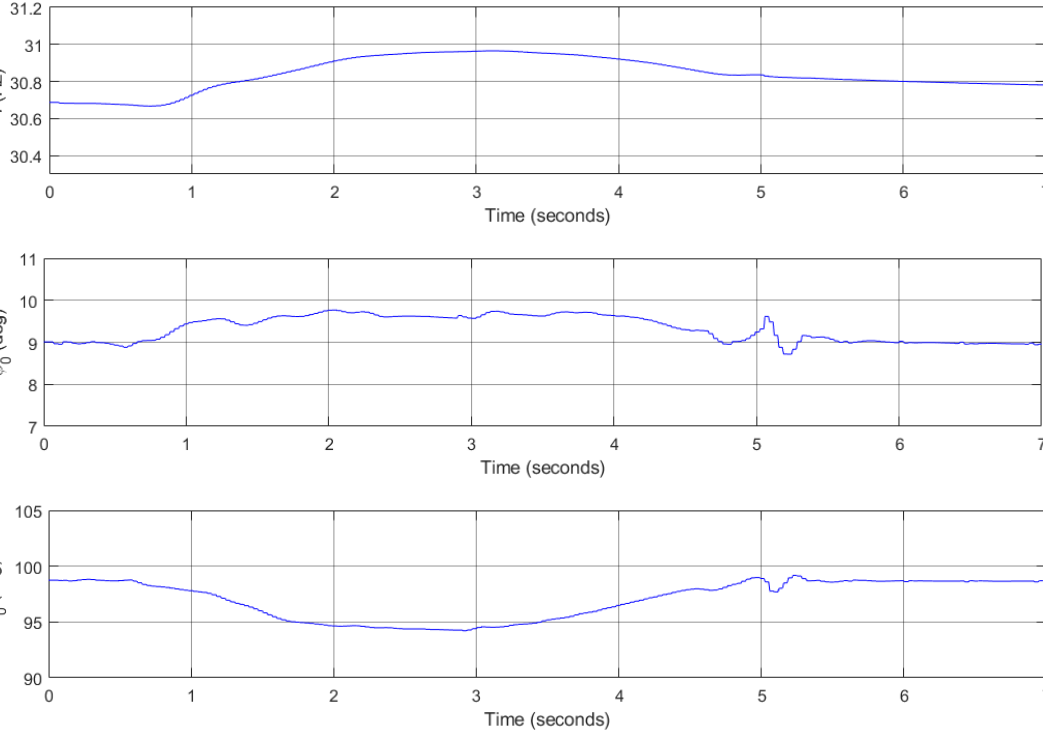
Figure 24. Flight control inputs for trajectories tracking control of nonlinear FWMAV model (case 1).